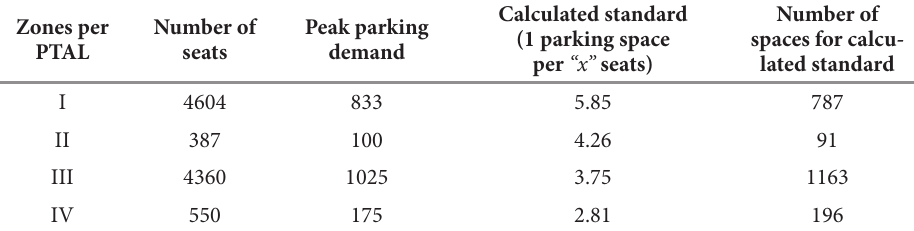
Table 9. Analysis of obtained parking spaces per zones Zones per PTAL